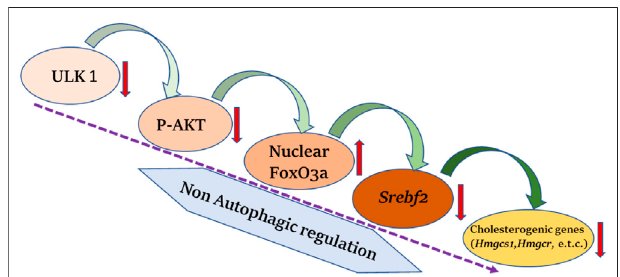
FIGURE 2 | ULK1 and hepatic cholesterol biogenesis. Uncoordinated- 51-like kinases 1 (ULK1) via a non-autophagic mechanisms regulates the biosynthesis of hepatic mevalonate/cholesterogenic genes. Loss of ULK1 leadstoinhibitionofproteinkinaseB(AKT)mediatedForkheadboxclass O 3a (FOXO3a) regulation in liver cells, wherein activated FoxO3a translocate to the nucleus and inhibits the transcription of sterol regulatory element binding factor 2 ( Srebf2 ) required for the synthesis of cholesterol biogenesis